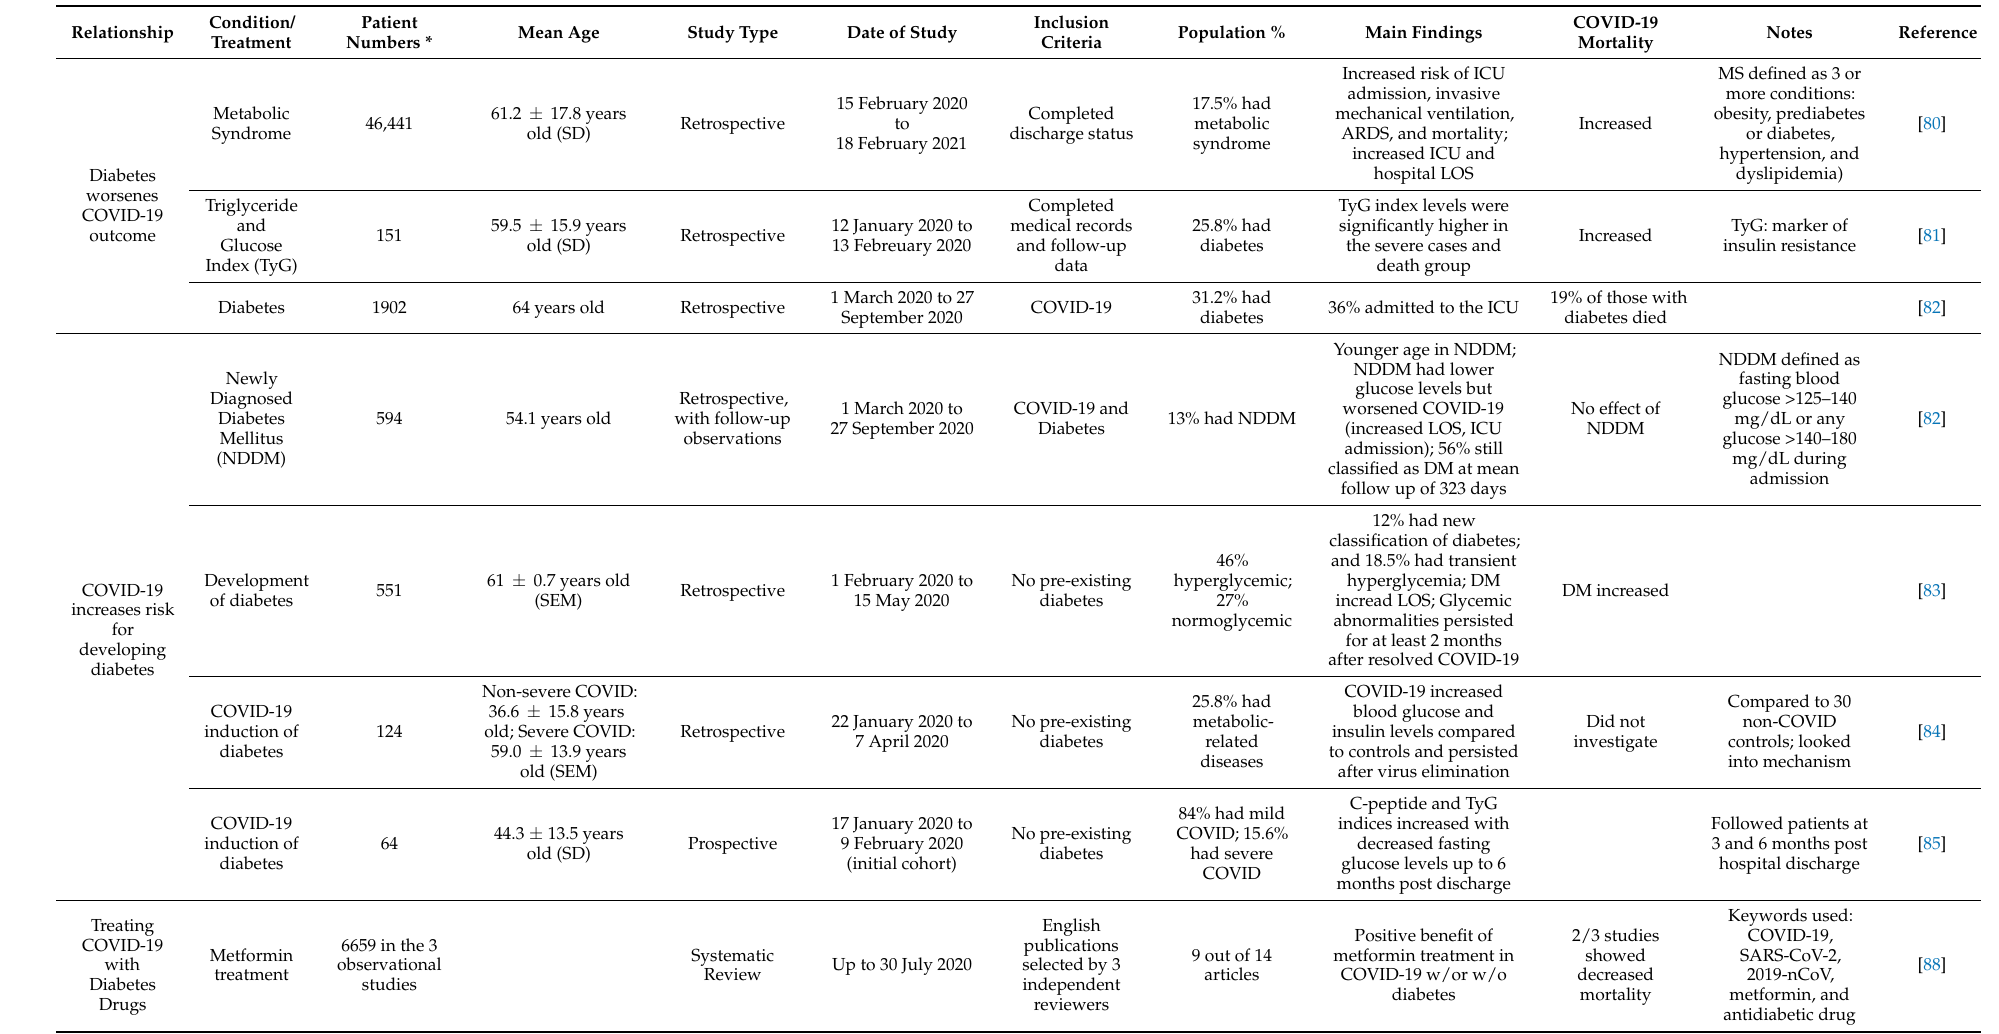
Table 1. Peripheral insulin resistance and